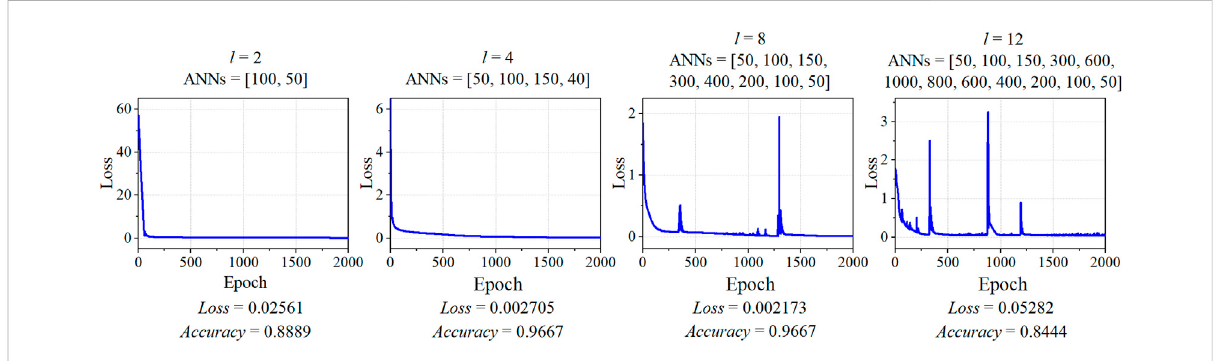
FIGURE 5 Loss of training process, and Accuracy of test datasets, for the number of hidden layers l ∈ {2, 4, 8, 12} with different ANNs, for learning rate η = 0.001.